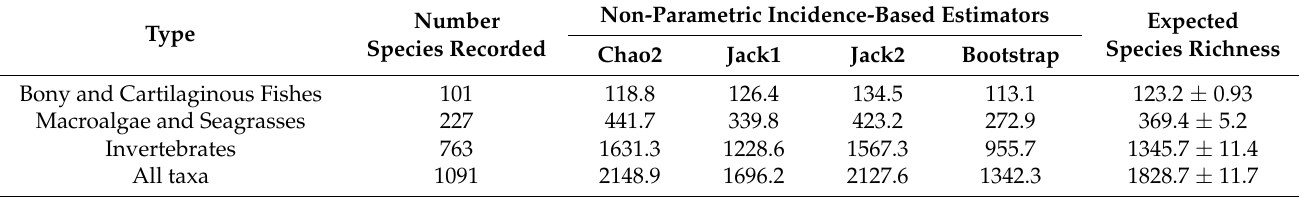
Table 1. Species richness of marine biota documented from Blue Cavern Onshore SMCA. Expected species richness was estimated using the mean value ( ± 1 SE) of four non-parametric incidence-based estimators (Chao and Chiu 2016) of the number of bony and cartilaginous fishes, macroalgae and plants, invertebrates, as well as all marine taxa recorded in this